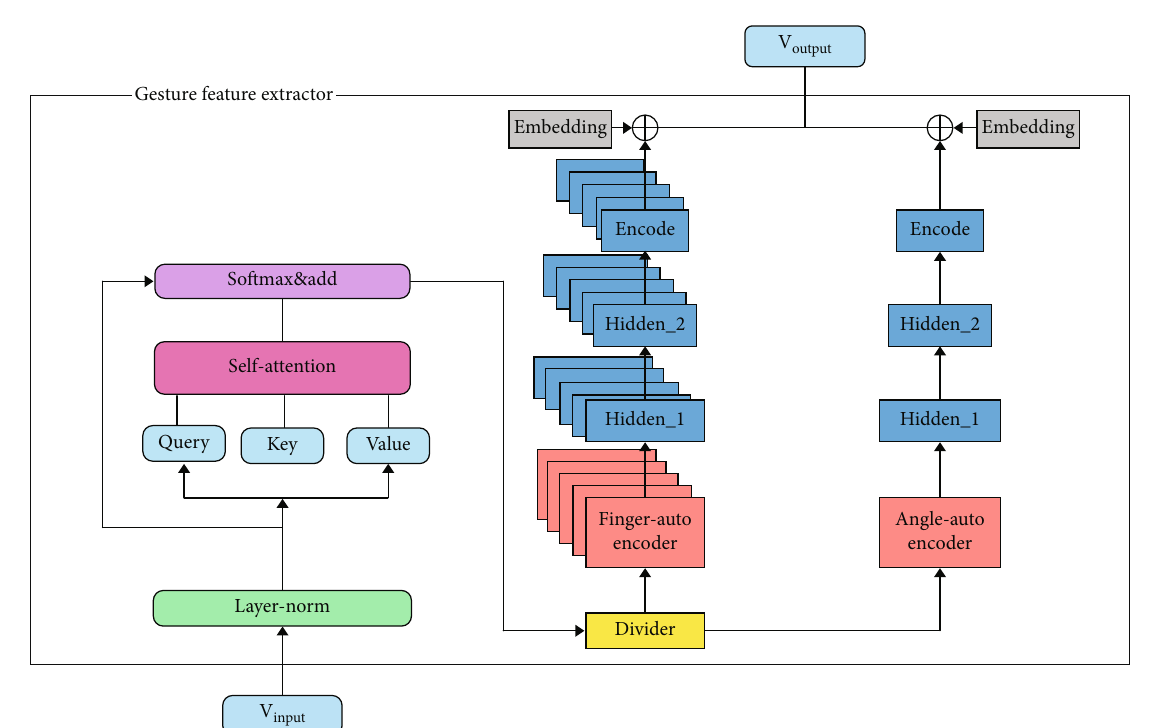
Figure 4: Architecture of the gesture feature extractor.